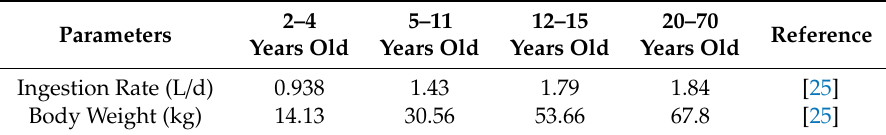
Table 3. Exposure assumptions for rural Mexican